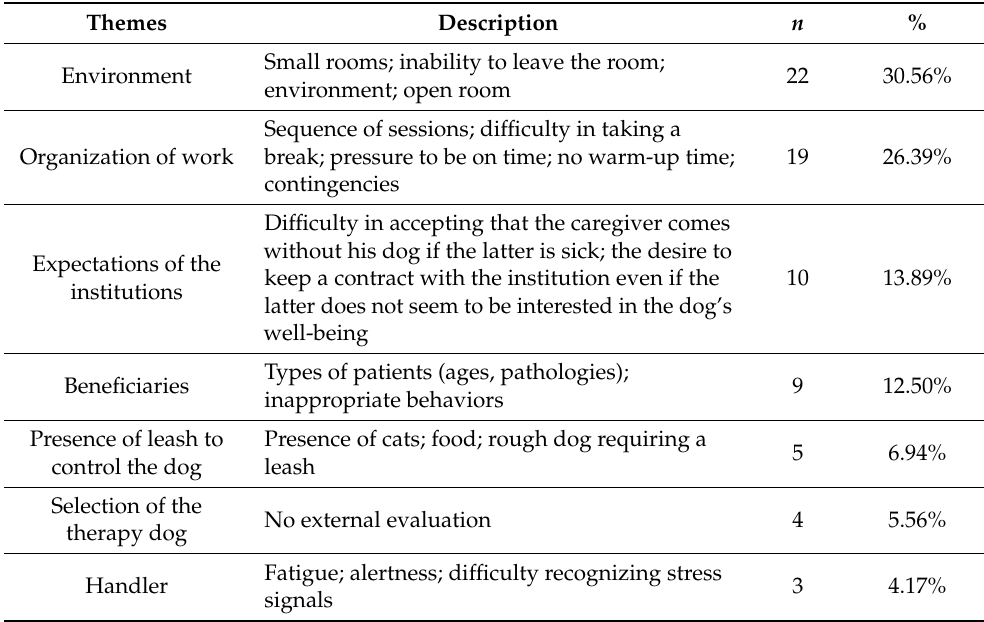
Table 7. This table represents the answers to the question “What limitations do you encounter that prevent you from following these recommendations?”. n = 57 complete answers. Total of 72 terms coded grouped into 7 themes; presented in descending